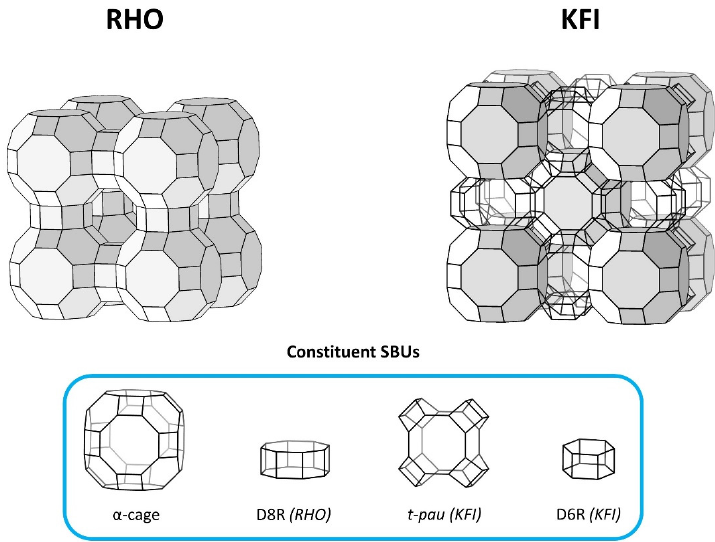
Figure 1. Structure of the RHO and KFI framework types. Included are the constituent SBUs: the α -cage, the double 8-ring (D8R), t-pau unit and the double 6-ring (D6R). For the latter three the code in parenthesis indicates the framework that this SBU belongs to exclusively. The framework struc- tures are shown with the α -cages and D8Rs as solid polyhedra. 2. Methods